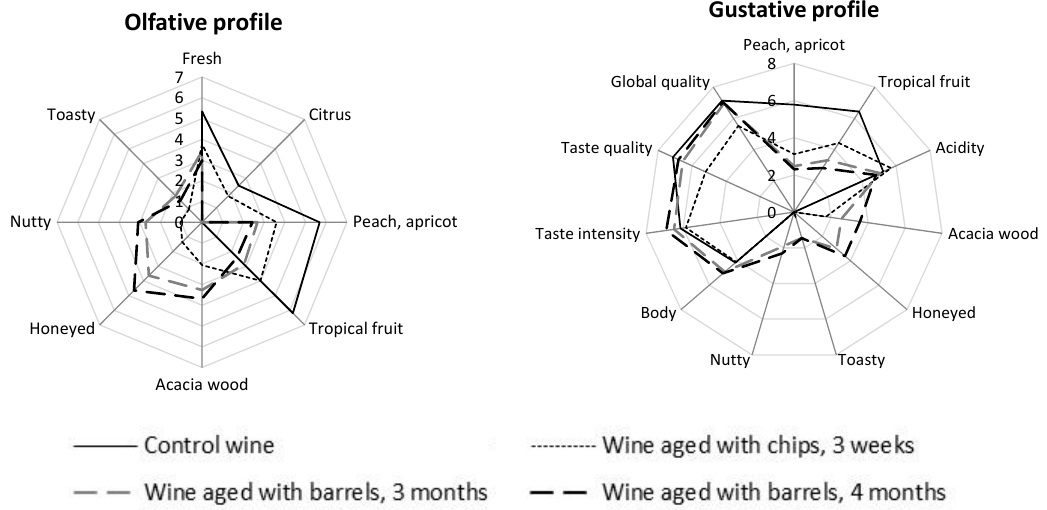
Figure 1. Olfactive and gustative profiles of aged wines with the acacia treatments best scored in comparison with sensorial profiles of control wines.